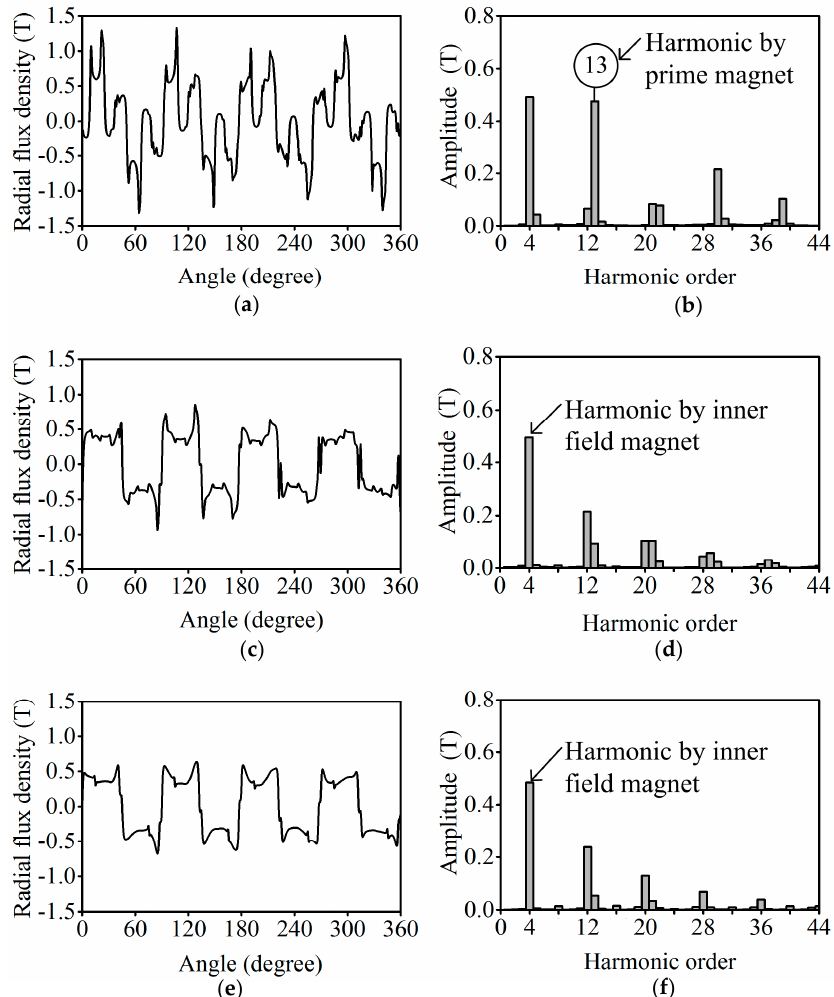
Figure 5. The magnetic gear flux density characteristics in middle of three inner air-gaps: ( a ) Flux density between inner stator and inner field PM; ( b ) FFT from ( a ); ( c ) Flux density between inner field PM and inner iron ring; ( d ) FFT from ( c ); ( e ) Flux density between inner iron ring and prime PM; ( f ) FFT from ( e ).